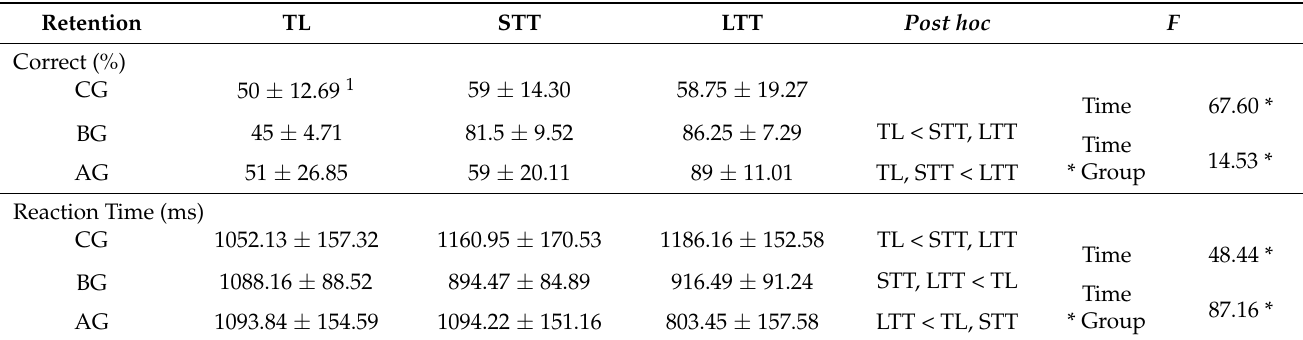
Table 2. Change of new cognitive skill retention (N =